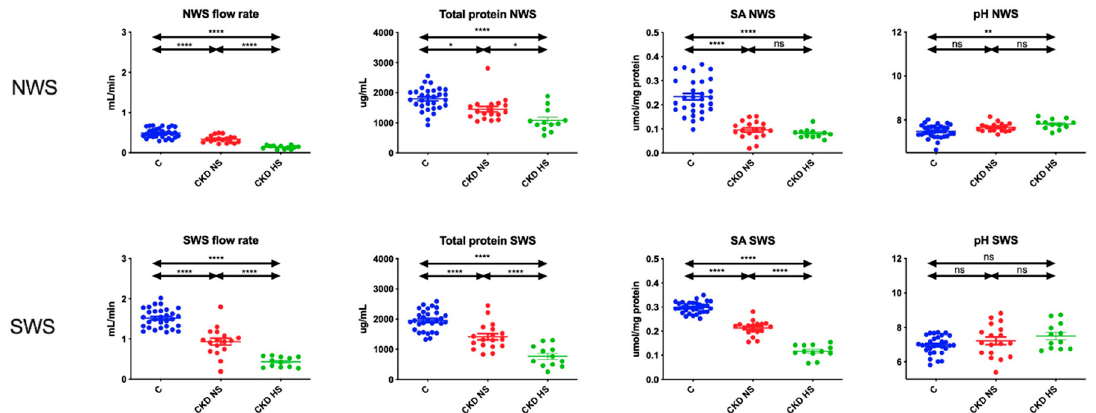
Figure 1. Salivary gland function and salivary pH of children with chronic kidney disease (CKD) and healthy controls. C—Healthy controls; CKD NS—CKD patients with normal salivary secretion; CKD HS—CKD patients with reduced salivary secretion; NWS—Non-stimulated whole saliva; SA—Salivary amylase; SWS—Stimulated whole saliva. Di ff erences statistically significant at: * p < 0.05, ** p < 0.005, **** p < 0.0001.